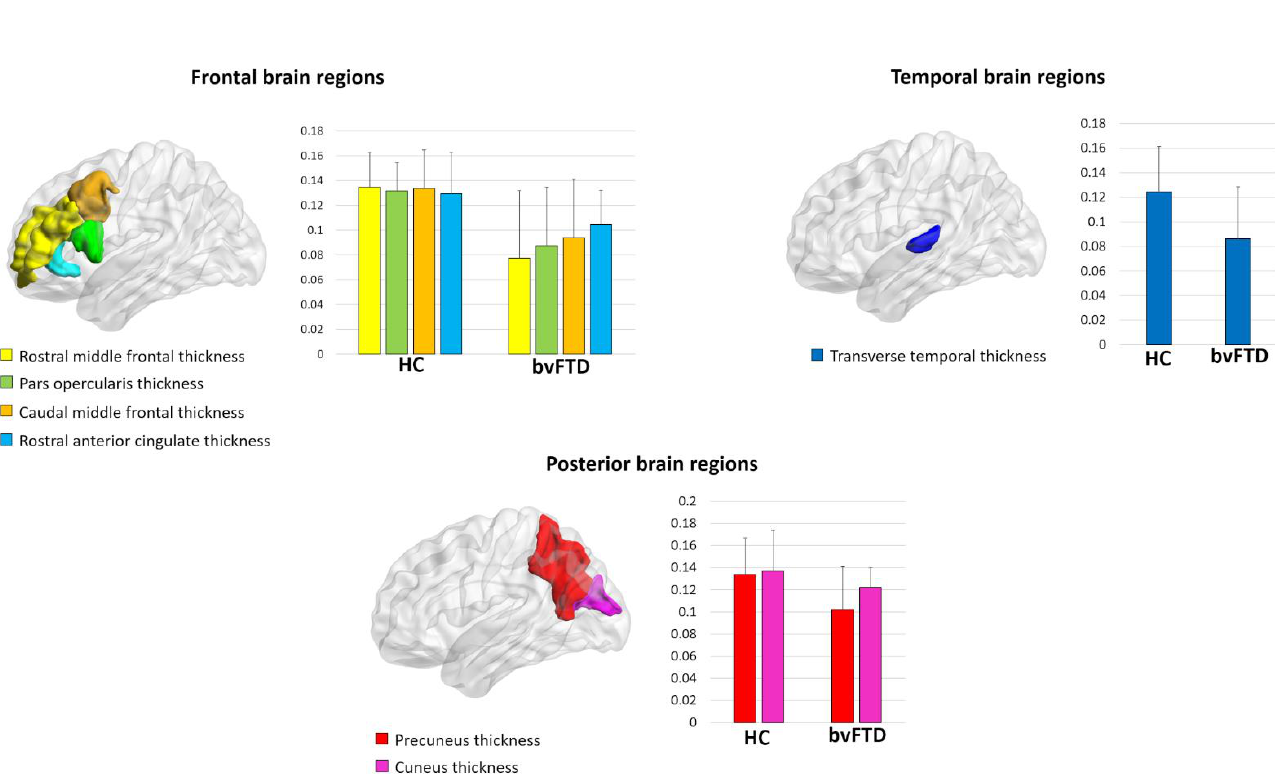
Figure 1. Regions showing decreased local efficiency in behavioral variant frontotemporal dementia (bvFTD) patients compared to healthy controls (HC). Table 3. Main effect of the group in the local efficiency and clustering coefficient. Local